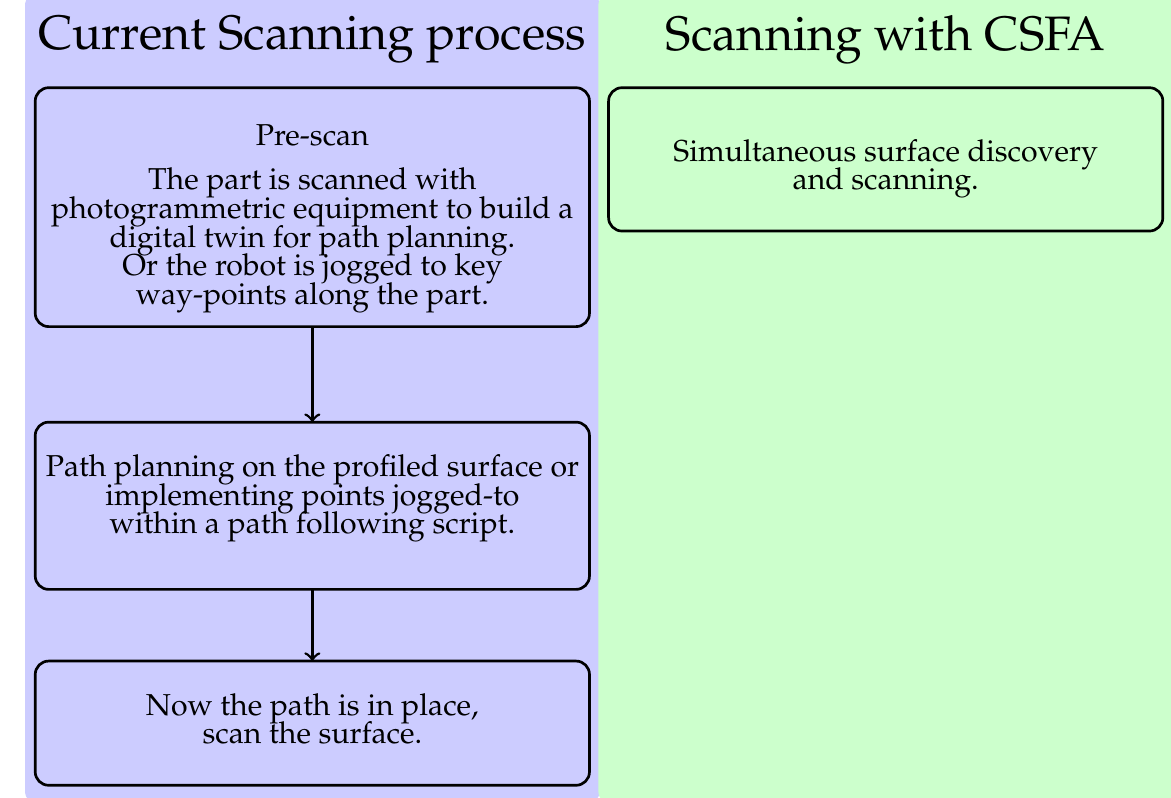
Figure 3. The one-step process enabled by the CSFA removes the necessity of accurate digital-twins and world-frame calibration, or lengthy robotic jogging procedures.